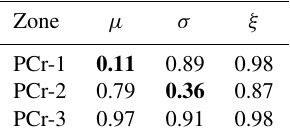
Table 2. Bhattacharyya coefficients applied to posterior densities of the GEV parameters, before and after 1994, for each region. Bold values indicate coefficients below the reference value of